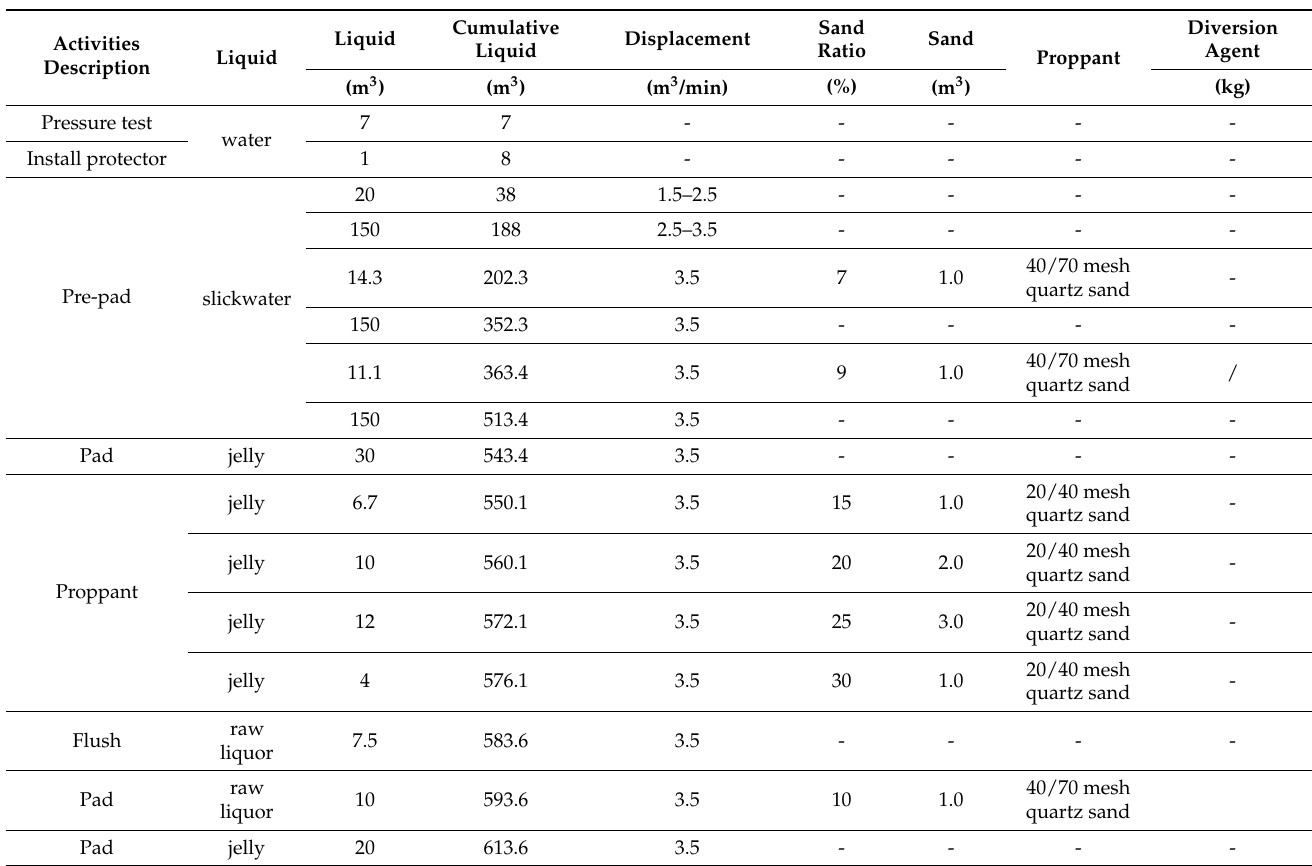
Table 4. Fracturing pump injection procedure of lower layer of well